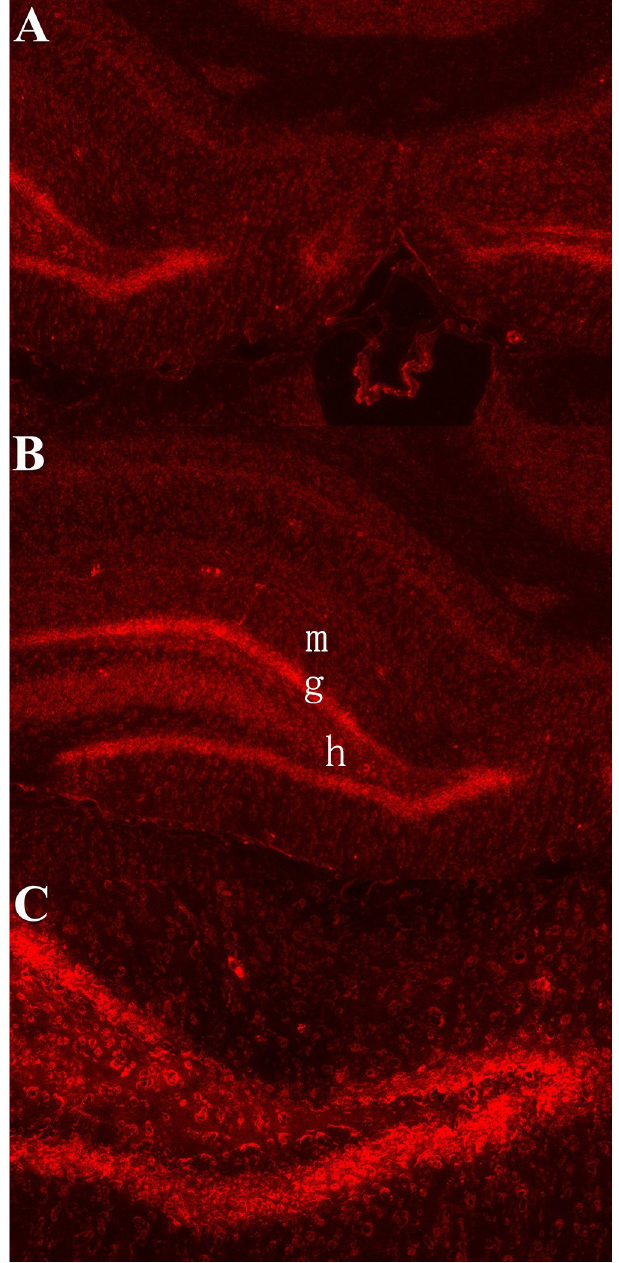
Fig 1. Histological verification of virus infection in hippocampus. (A and B) Representative photomicrographs showing mCherry fluorescence within the hippocampus. (C) Higher magnification images showing mCherry fluorescence in the DG. m, molecular layer; g, granule cell layer; h, hilus; Red = mCherry; DG, dentate gyrus.